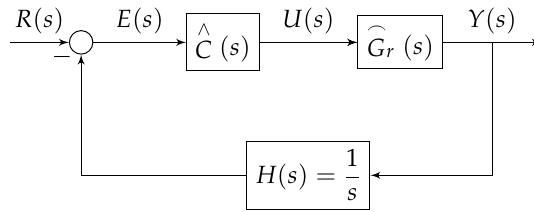
Figure 4: Closed-loop ROCIP with a fractional-order proportional-integral-derivative (FOPID) controller.